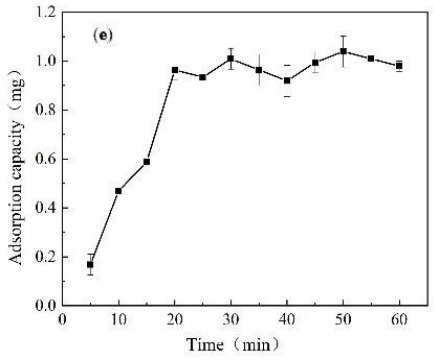
Figure 5. The effect of ( a ) resin addition on the ammonia nitrogen adsorption capacity, ( b ) the initial ammonia nitrogen concentration on the ammonia nitrogen adsorption capacity and ( c ) the ammonia nitrogen adsorption ratio, ( d ) pH and ( e ) time on the ammonia nitrogen adsorption capacity.